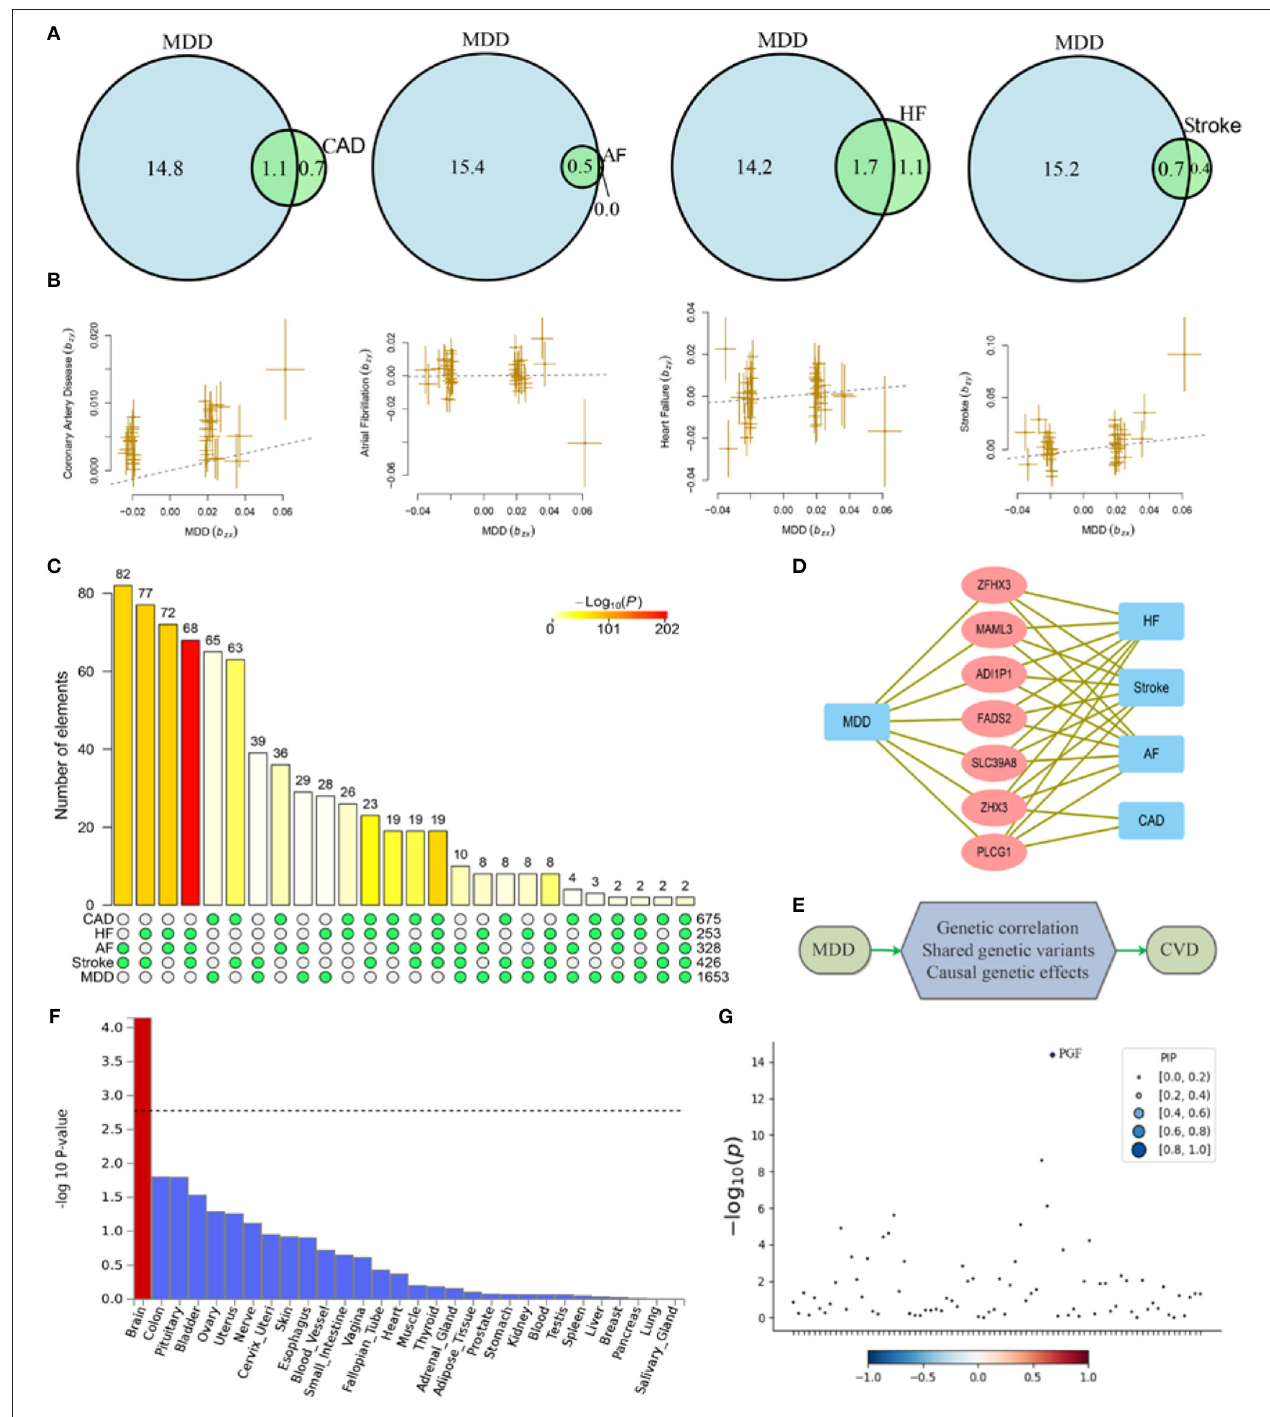
FIGURE 1 | Shared causal variants and causal effects between MDD and CVD. MDD, major depressive disorder; HF, heart failure; AF, atrial fibrillation; CAD, coronary artery disease. (A) Venn diagrams of unique and shared causal variants between major depressive disorder and cardiovascular diseases. The numbers indicate the estimated quantity of causal variants (in thousands) per component, explaining 90% of SNP heritability in each phenotype. The size of the circles reflects the degree of polygenicity. (B) Causal effects of MDD on cardiovascular diseases. The dotted lines denote effect sizes (b xy ). (C) Overlapped genes between major depressive disorder and cardiovascular disease from GWAS-catalog. The matrix of solid and empty circles at the bottom illustrates the “presence” (solid green) or “absence” (empty) of the gene sets in each intersection. The numbers to the right of the matrix are set sizes. The colored bars on the top of the matrix represent the intersection